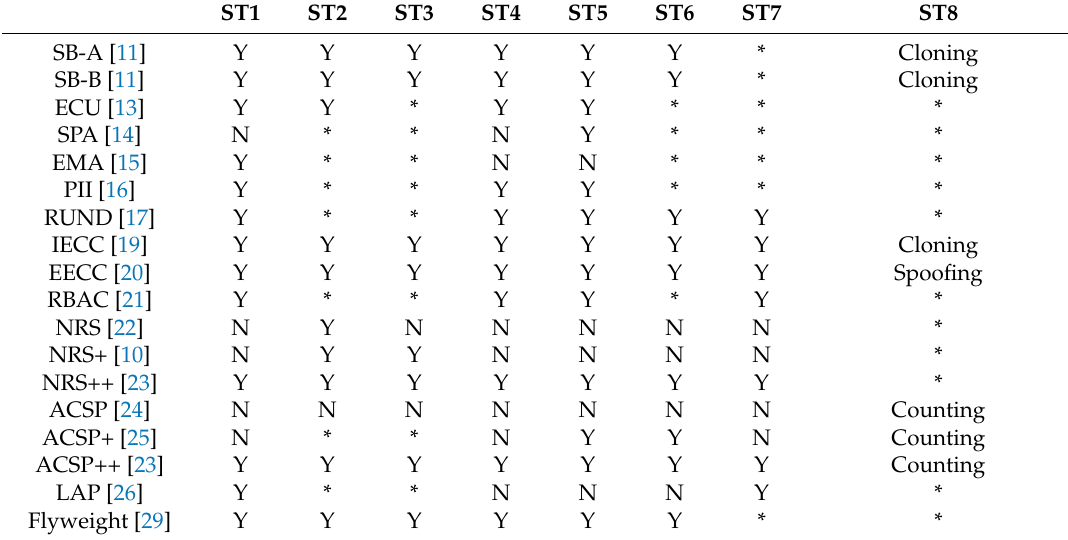
Table 3. Comparison of Various Security Threats